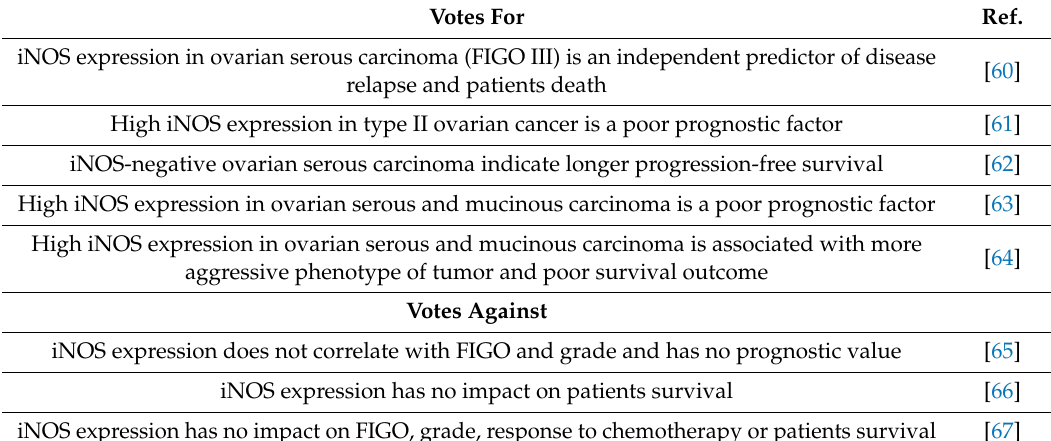
Table 1. Possibility of using iNOS expression in ovarian tumors as prognostic / prediction factor. Votes For Ref. iNOS expression in ovarian serous carcinoma (FIGO III) is an independent predictor of disease relapse and patients death